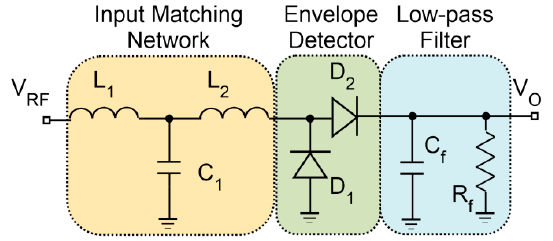
Figure 2. WuR architecture of the envelope detector with discrete components.